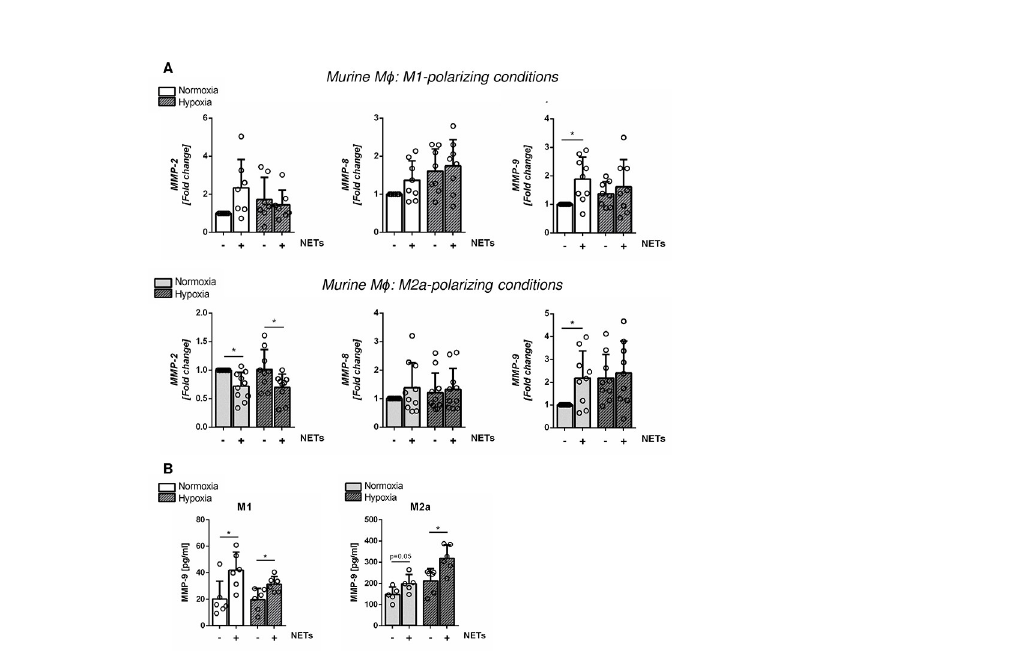
Fig 6. Effect of NETs on the expression of MMPs in polarized murine bone marrow-derived macrophages. (A) Relative gene expression of MMP-2 , MMP-8 and MMP-9 in M1- and M2a-polarized murine macrophages, cultured under normoxia or hypoxia in the presence or absence of NETs (1000 ng/ml) was analyzed by Real-time PCR. n = 7–10. (B) MMP-9 protein levels were quantified in culture supernatants by Elisa. n = 6. � P < 0.05 (One-sample t test, Mann-Whitney